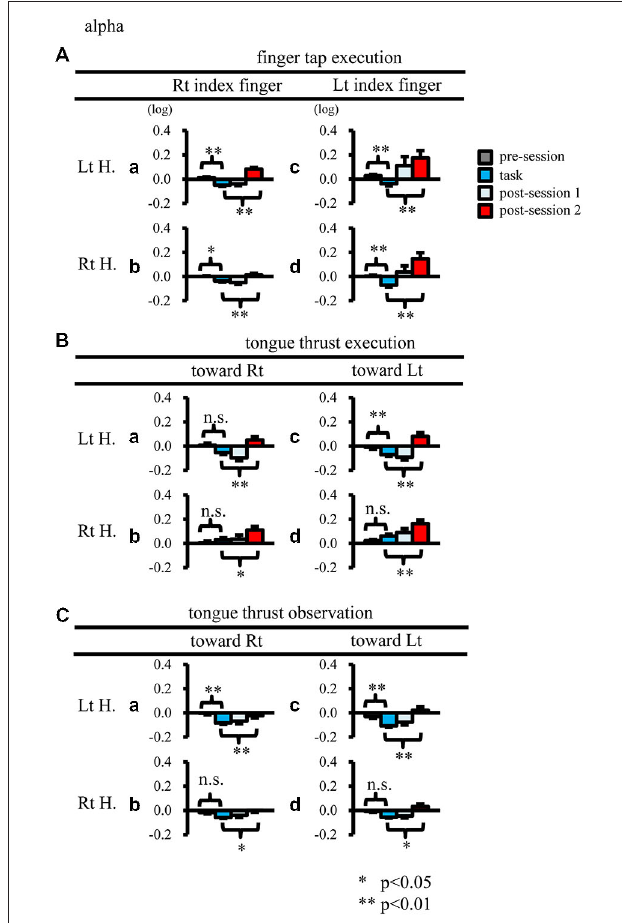
FIGURE 6 | Logarithmic EEG power ratios (ERD negative; ERS positive) for the mu rhythm . The plot organization is as that mentioned in Figure 4 . H, hemisphere; Lt, left; Rt, right. ∗ p < 0.05; ∗∗ p < 0.01.